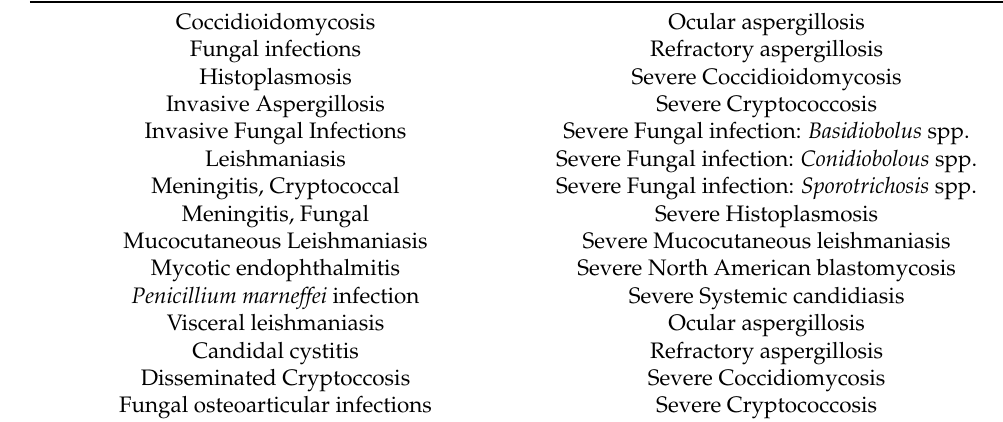
Table 1. Uses of Amphotericin B (systemic) Source: Adapted from DrugBank Online [9].